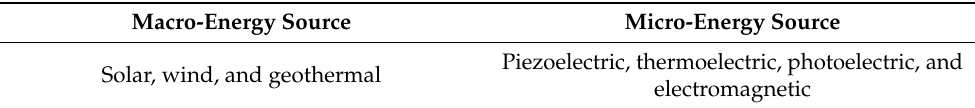
Table 1. Energy harvesting field according to the natural energy